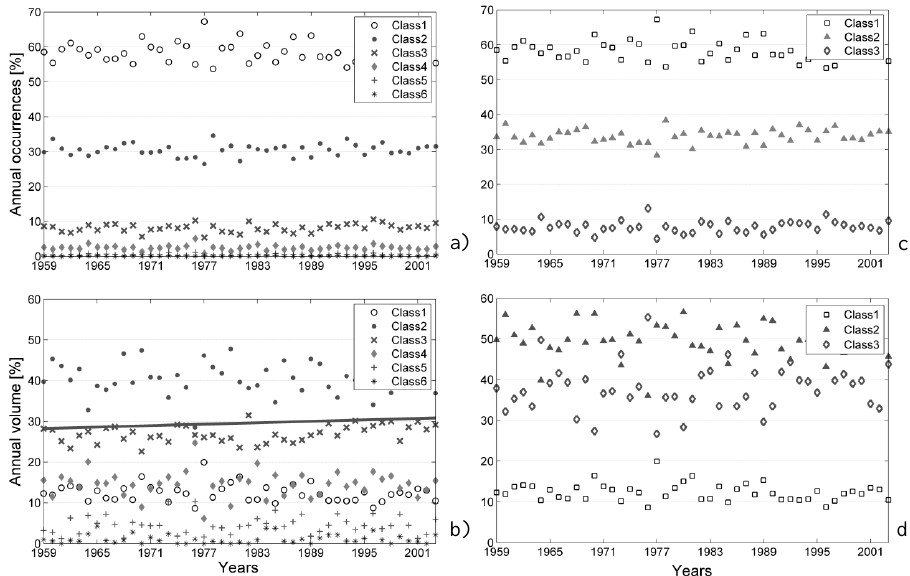
Fig. 5. Daily rainfall analysis: rainfall contribution to annual occurrences from each class ( a and c ) and to the total annual volume from each class ( b and d ) as regional average over all the stations, based on classification A ( a and b ) and classification B ( c and d ). The presence of a straight line indicates trend existence.